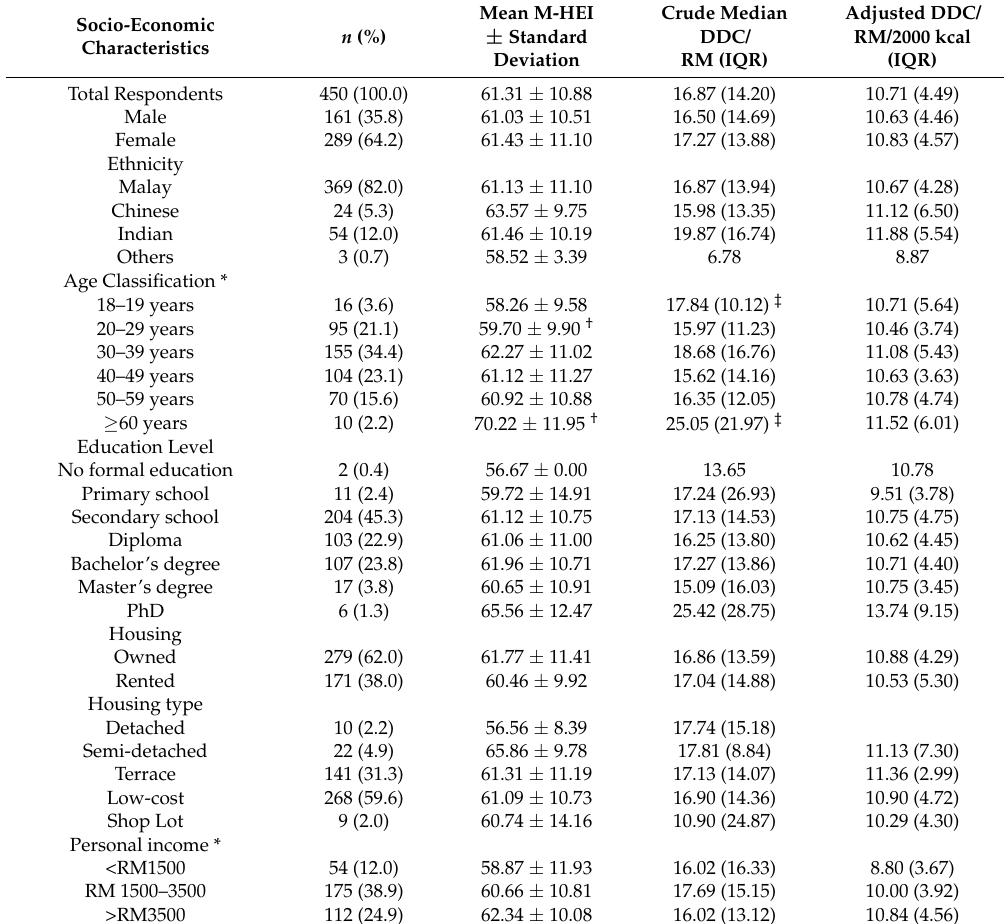
Table 1. Socio-economic characteristics by mean Malaysian-Healthy Eating Index (M-HEI) scores and median Daily Dietary Cost